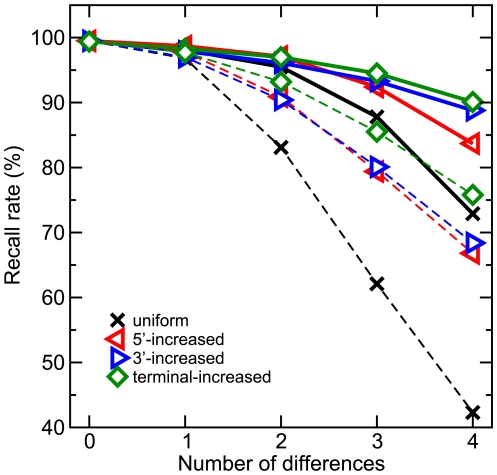

segemehl recall rates for varying difference values and distributions.Recall rates are depicted for k = 0 (dashed) and k = 1 (solid). For terminal–, 3′– and 5′– increased difference distributions, segemehl achieves a recall rate above 80% for reads with 4 errors.